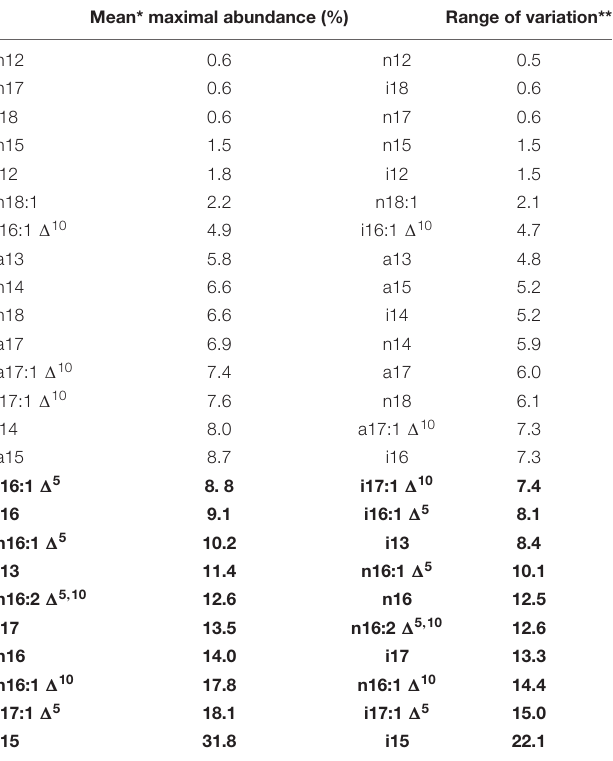
TABLE 1 | Fatty acids identified in B. cereus ordered by mean maximal relative abundance (left) and range of variation observed over all the strains (ATCC 10876, ATCC 14579 T , and MM3), growth temperatures, and times considered in study. Mean* maximal abundance